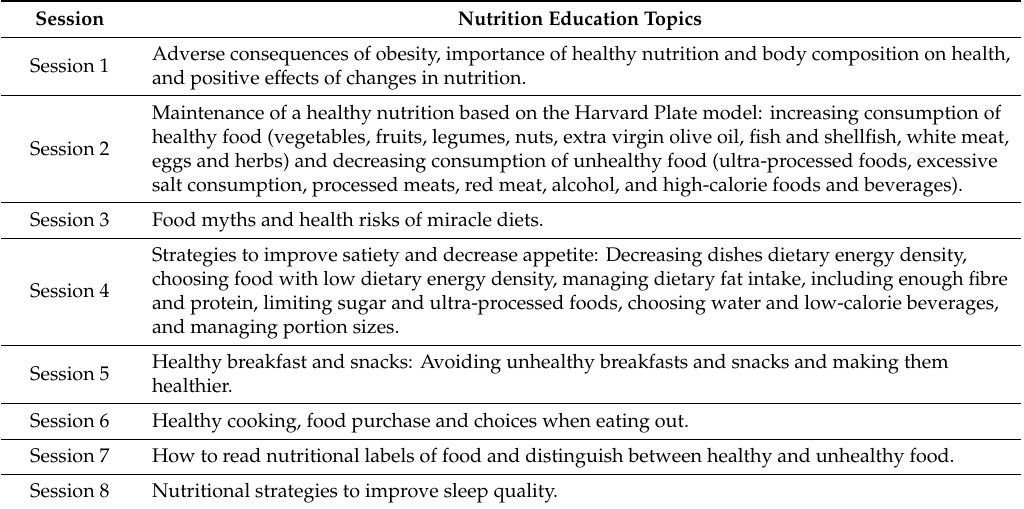
Table 4. Description of nutrition education per